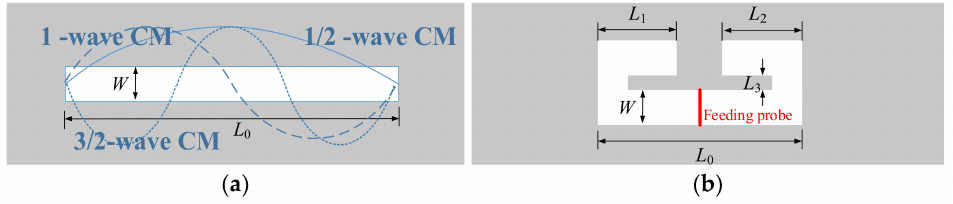
Figure 2. Geometry of the different line-slot antenna. ( a ) line slot antenna, ( b ) folding-line slot antenna.